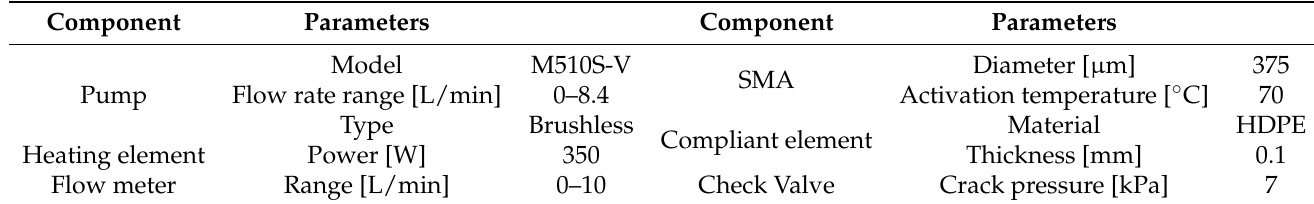
Figure 13. Constant-Flow (CFSMALA) experiment setup. Table 2. CFSMALA experiment components and